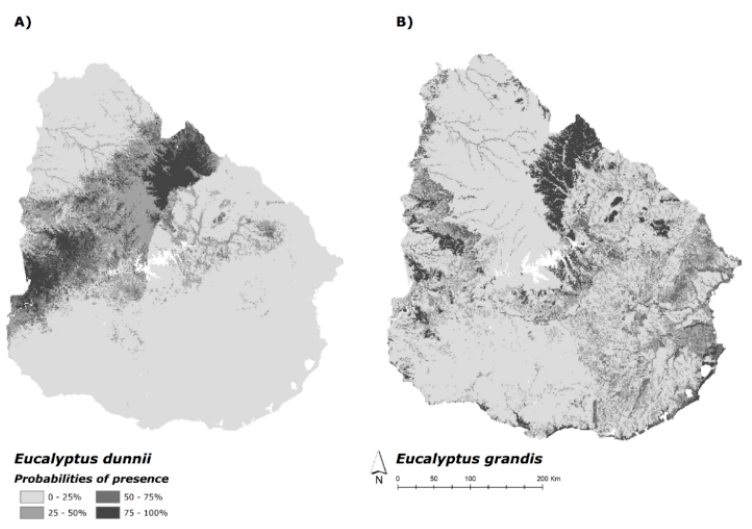
Figure 4. Current probability of occurrence of Eucalyptus dunnii ( A ) and E. grandis ( B ) in Uruguay. The potential distribution was mapped in both cases with the average ensemble model. Forests 2020 , 11 , x FOR PEER REVIEW